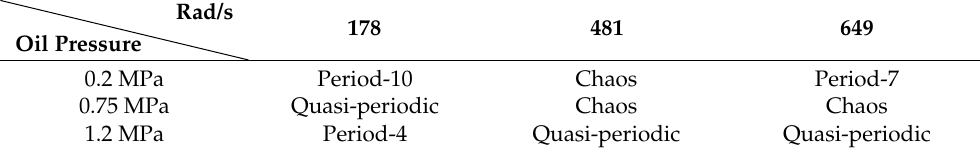
Figure 13. Trajectory of shaft center with the Poincaré map ( left side ) and the power spectrum ( right side ) for the rotating shaft at different rotating speeds. Table 1. Rotor periodic motion as the speed rises under different oil